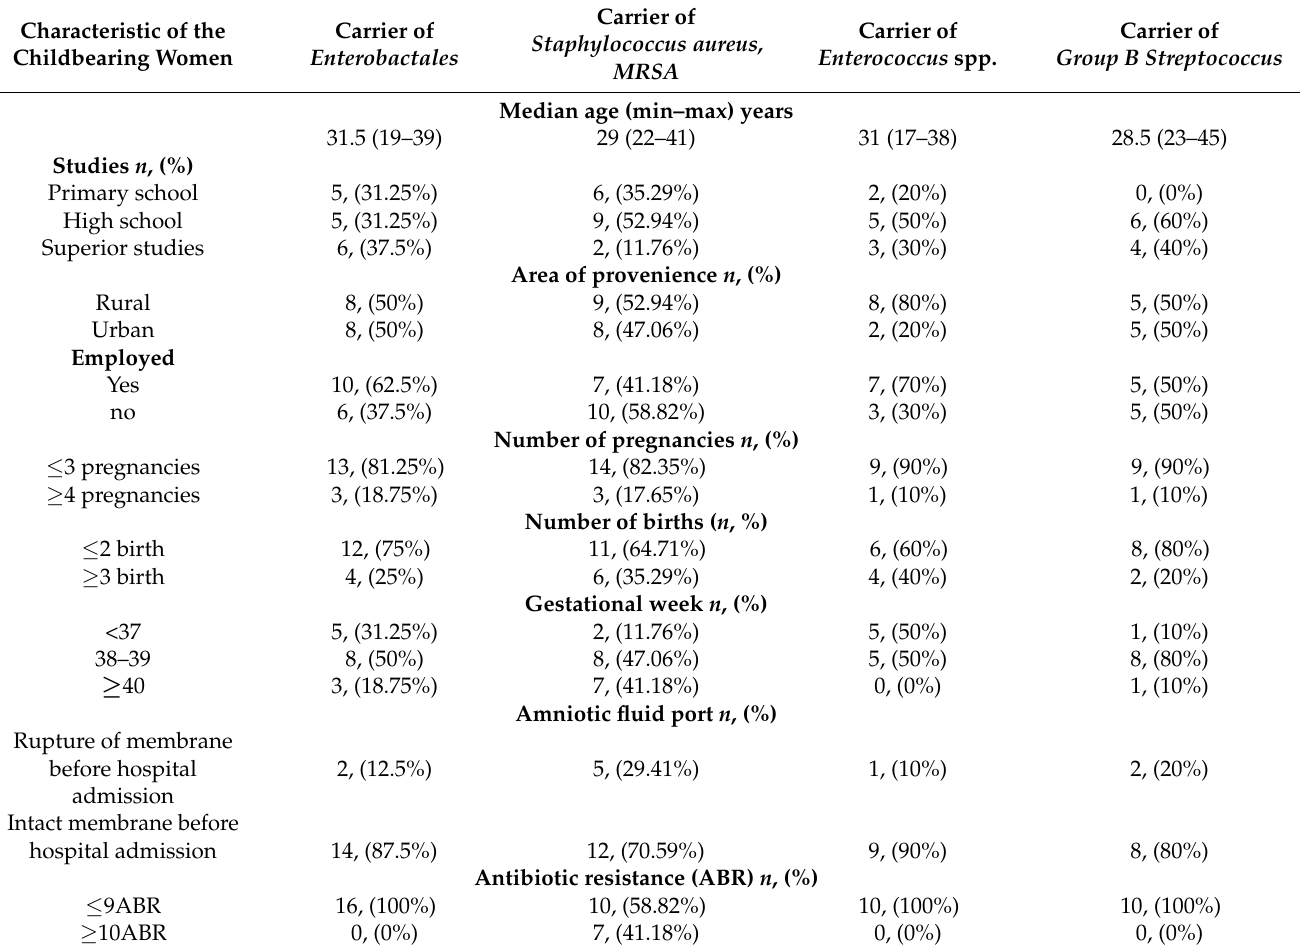
Table 2. Pregnancy status, sociodemographic, and educational characteristics, baseline clinical data of 53 participating childbearing women that tested positive for bacteria and gave birth